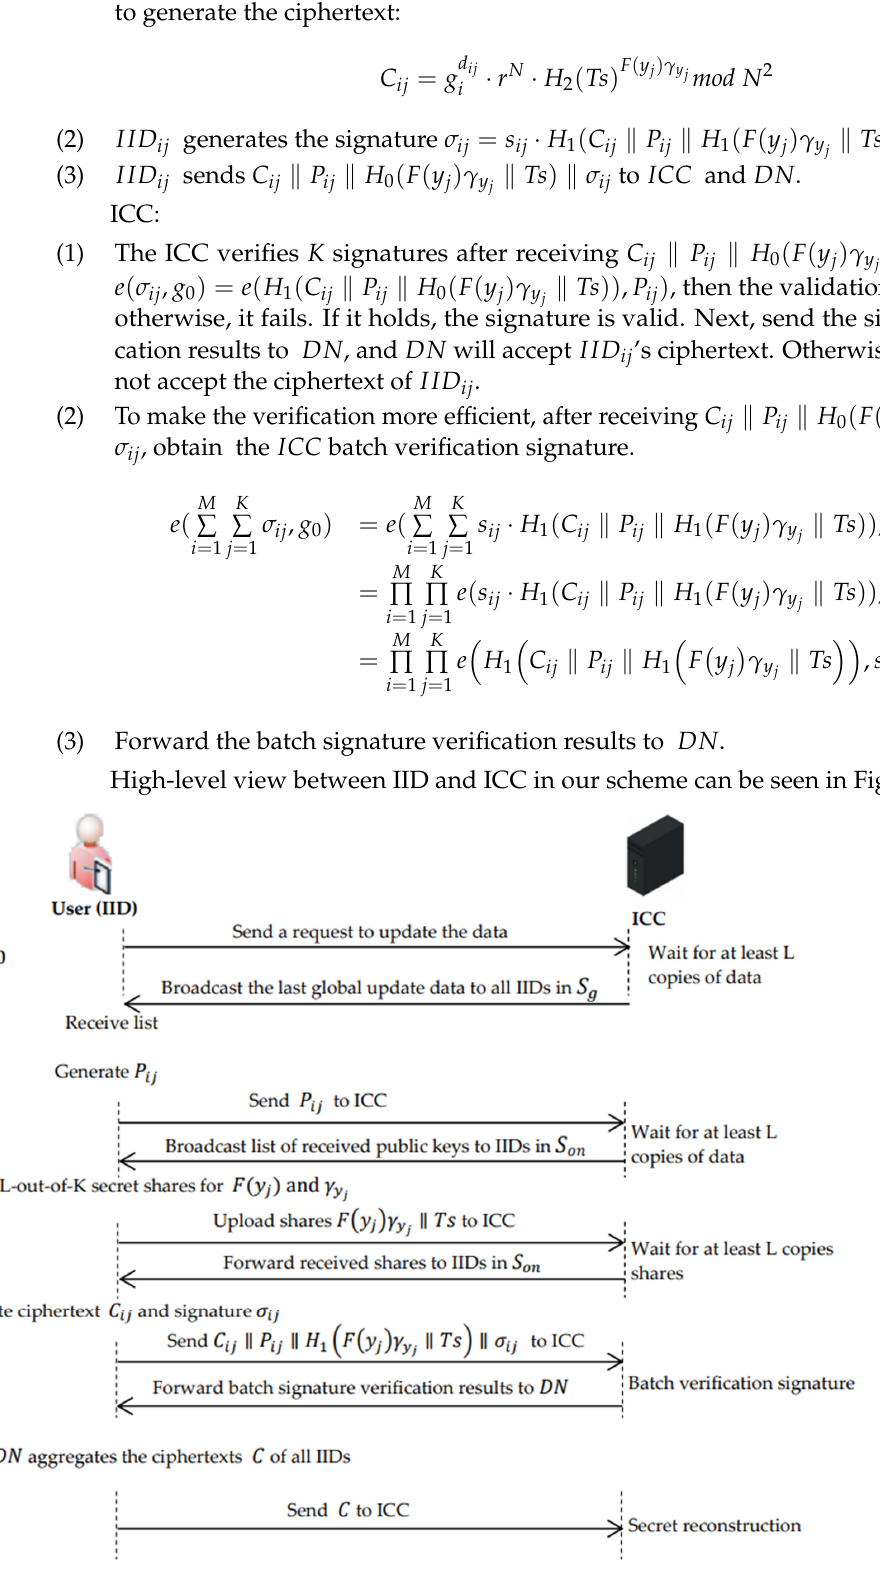
Figure 2. High-level view between IID and ICC in our